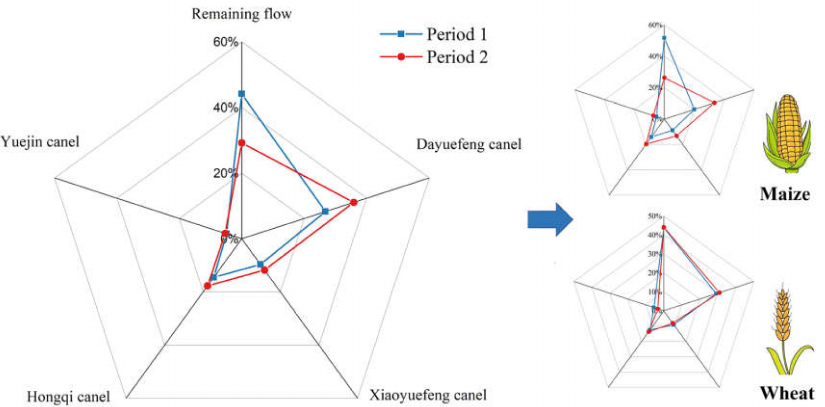
Figure 8. Radar map of water use changes in two